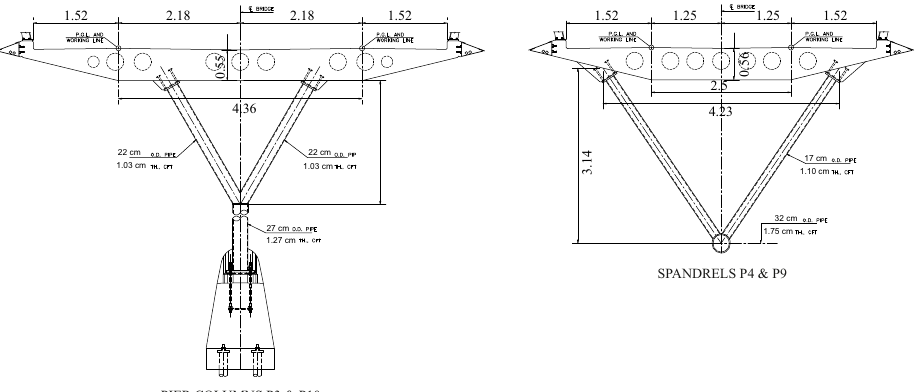
Figure 2. Detail of one Y-shaped pier ( left ) and of one spandrel ( right ). SI units. (Adapted from original drawings of PU Facilities and HNTB).